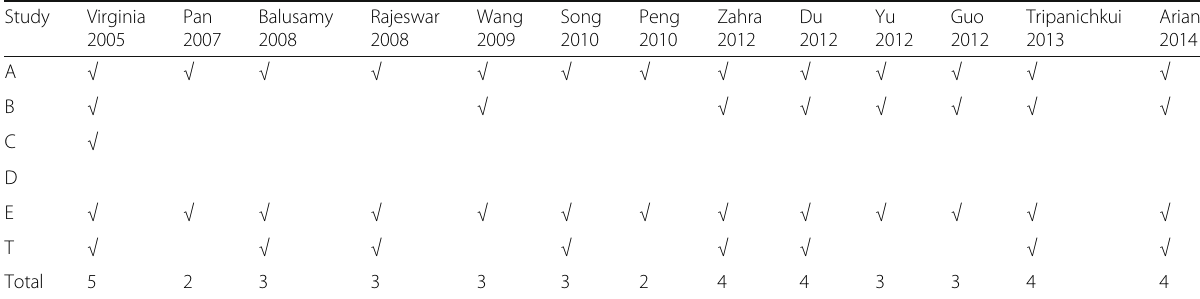
Table 2 Risk of bias of included studies Study